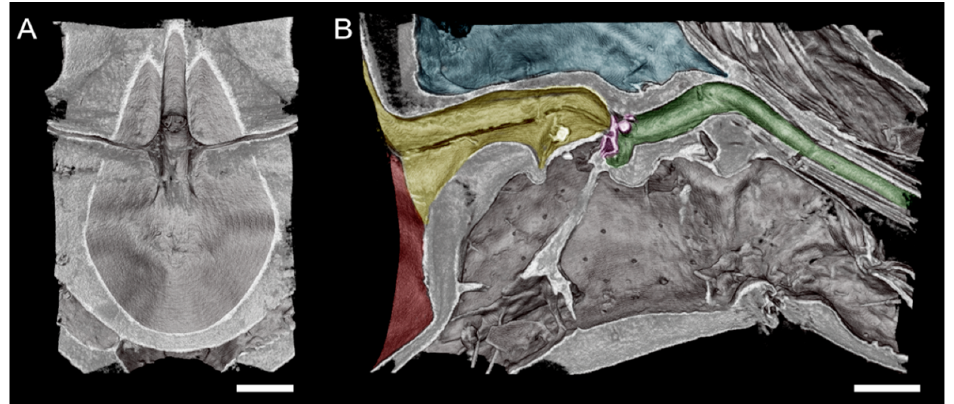
Figure 4. High ‐ magnification microCT images of a subvolume of the GWSS head targeting the cibarium and foregut where Xylella fastidiosa is known to form biofilms. A superior horizontal section exposing the cibarium chamber ( A ). An orthogonal view of the same subvolume of the GWSS head reveals the complexity of the pathway through the foregut and mouthparts ( B ). Red shaded area in shows the cibarium chamber, and yellow area shows precibarium). The precibarium valve (purple) is also visible with microCT imaging at this magnification, as well as the precibarial value’s pit (green). Bars = 50 μ m.